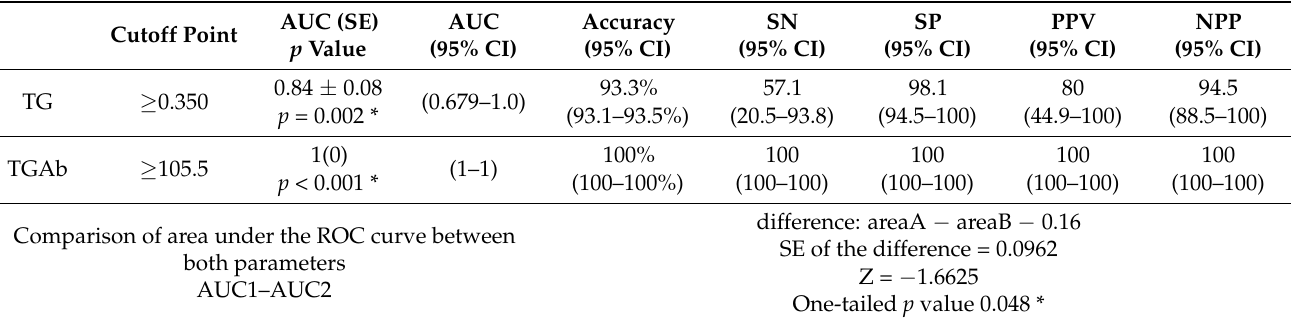
Table 5. The predictive performance of thyroglobulin and anti-TG for diagnosis of relapse among cases of thyroid cancer. Cutoff Point